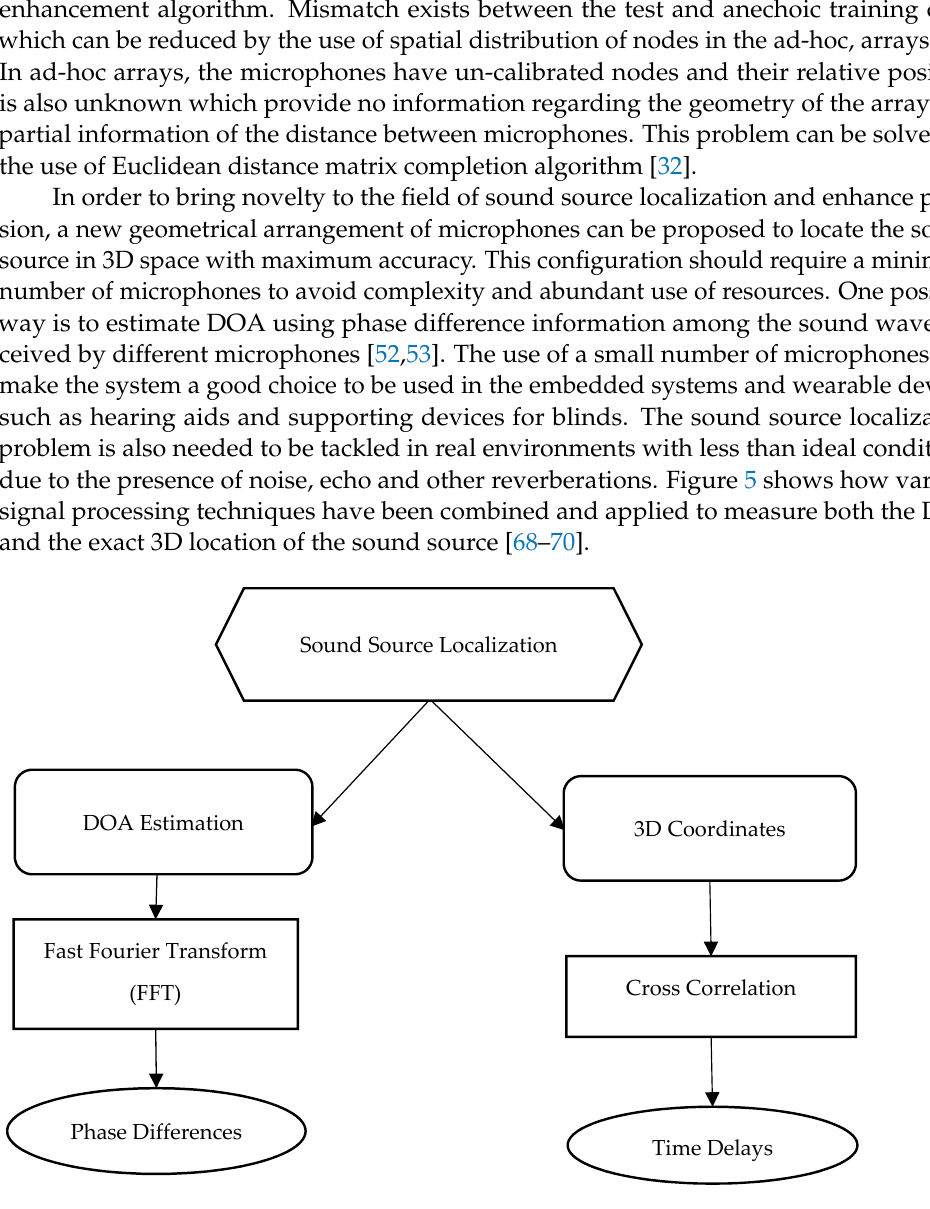
Figure 5. Sound source localization using DOA and 3D modeling.